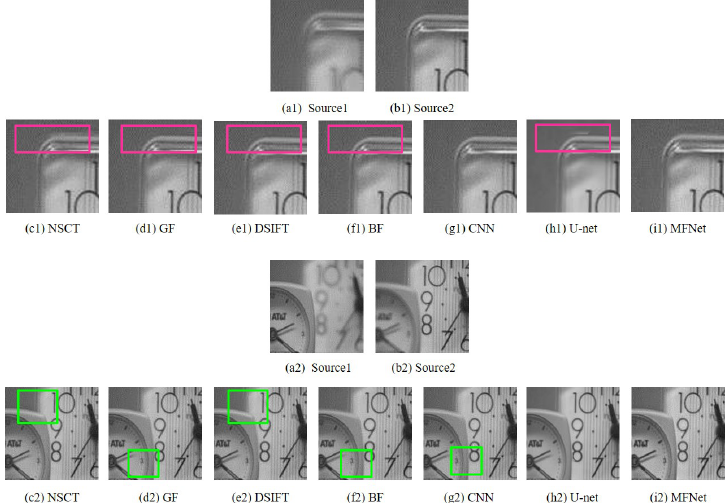
Figure 4. Magnified regions of the “Clock” source images and fused images obtained with different